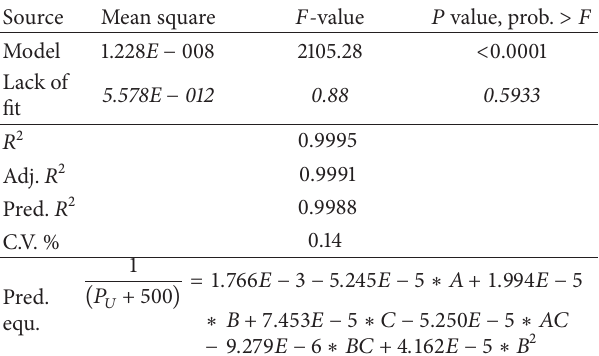
Table 5: Summary of ANOVA for the urea hydrolysis potential model